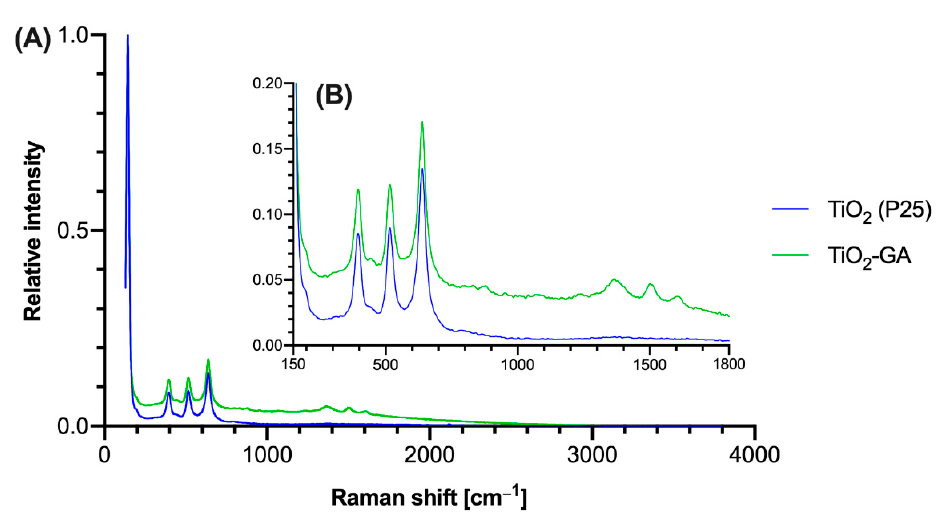
Figure 6. Raman spectra of analyzed materials TiO 2 and TiO 2 -GA. ( A ) Full spectrum in the range of 4000–0 cm − 1 , ( B ) presents inset in the range of 1800–150 cm − 1 with relative intensity below 0.2.